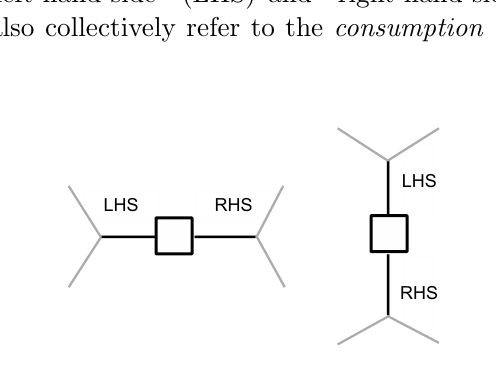
Figure 3.3: An illustration of the “sidedness” of a process. The designation of LHS and RHS is essentially